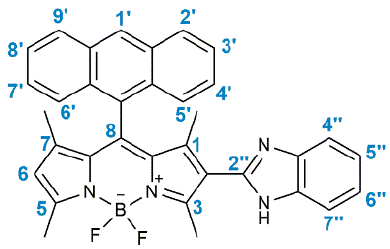
Figure 1. Structure of BODIPY derivative 2 .